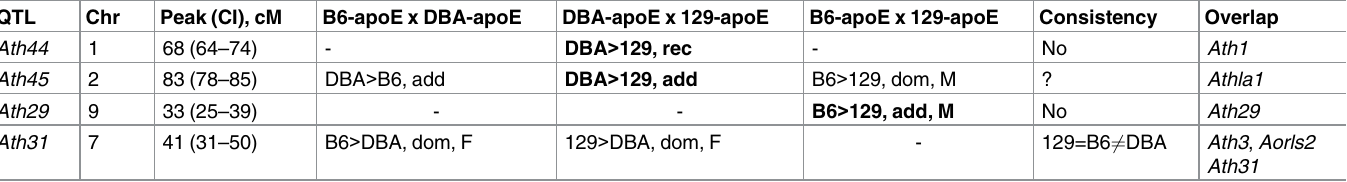
Table 5. QTLs for atherosclerotic lesions at root in three F2 intercrosses of Apoe-null mice on B6, DBA and 129 backgrounds.